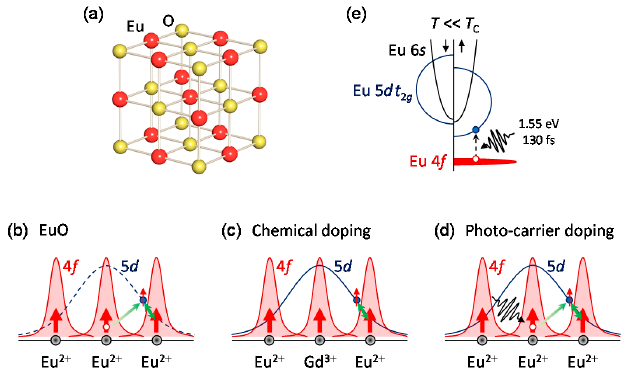
Figure 2. ( a ) Crystal structure of EuO. ( b ) Exchange interaction in undoped EuO via virtual 4 f –5 d excitation. ( c ) Introduction of 5 d electrons by chemical doping. ( d ) Introduction of 5 d electrons by